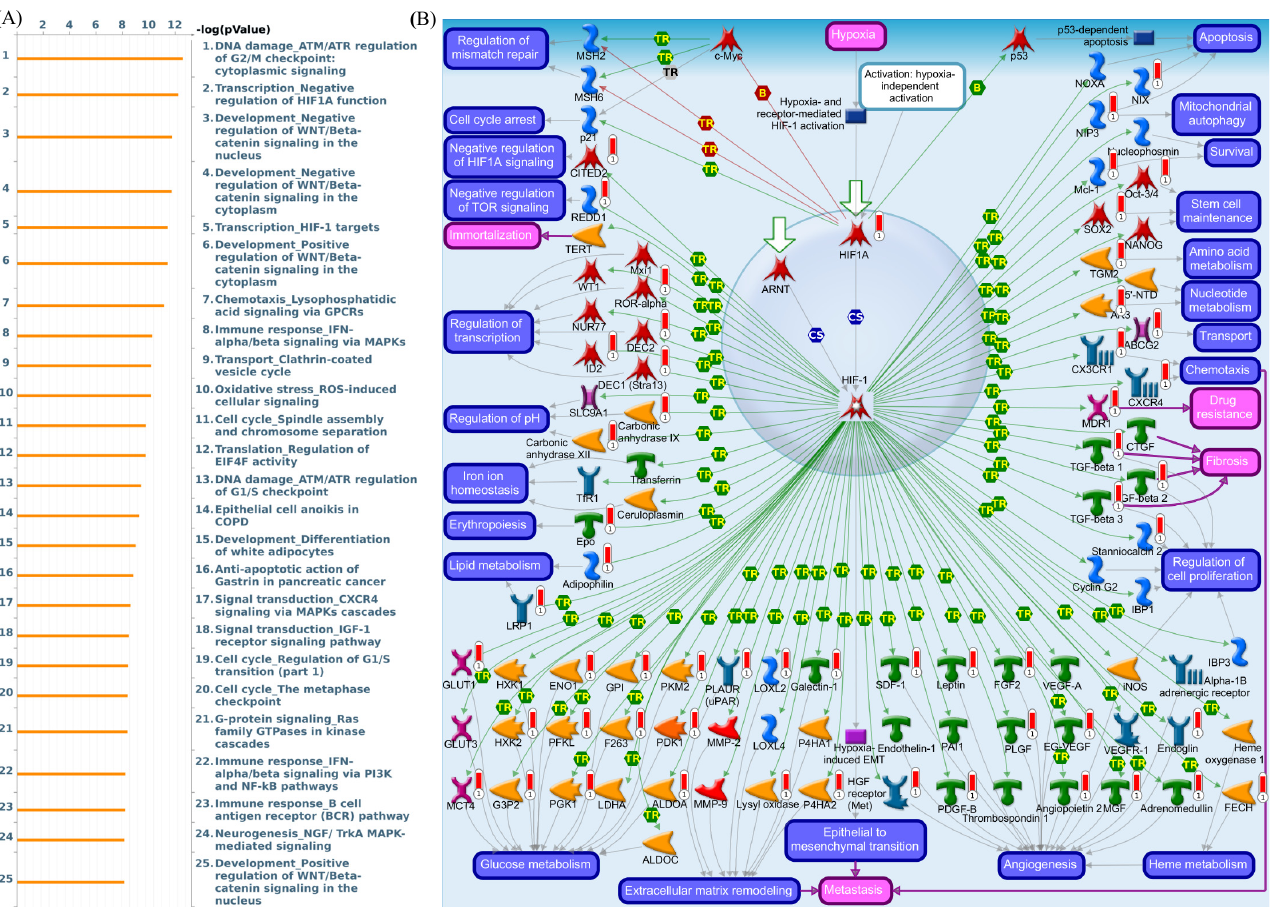
Figure 10. MetaCore pathway analysis of L-antigen 3 (LAGE3) co-expressed genes in a breast cancer database. ( A ) We exported LAGE3 co-expressed genes from TCGA and METABRIC breast cancer datasets to the MetaCore pathway analytical tool to find the relationship between our selected genes and enriched biological pathways. ( B ) The MetaCore pathway analysis of “biology processes” and “transcription_HIF-1 targets”-related pathways were correlated with breast cancer development.